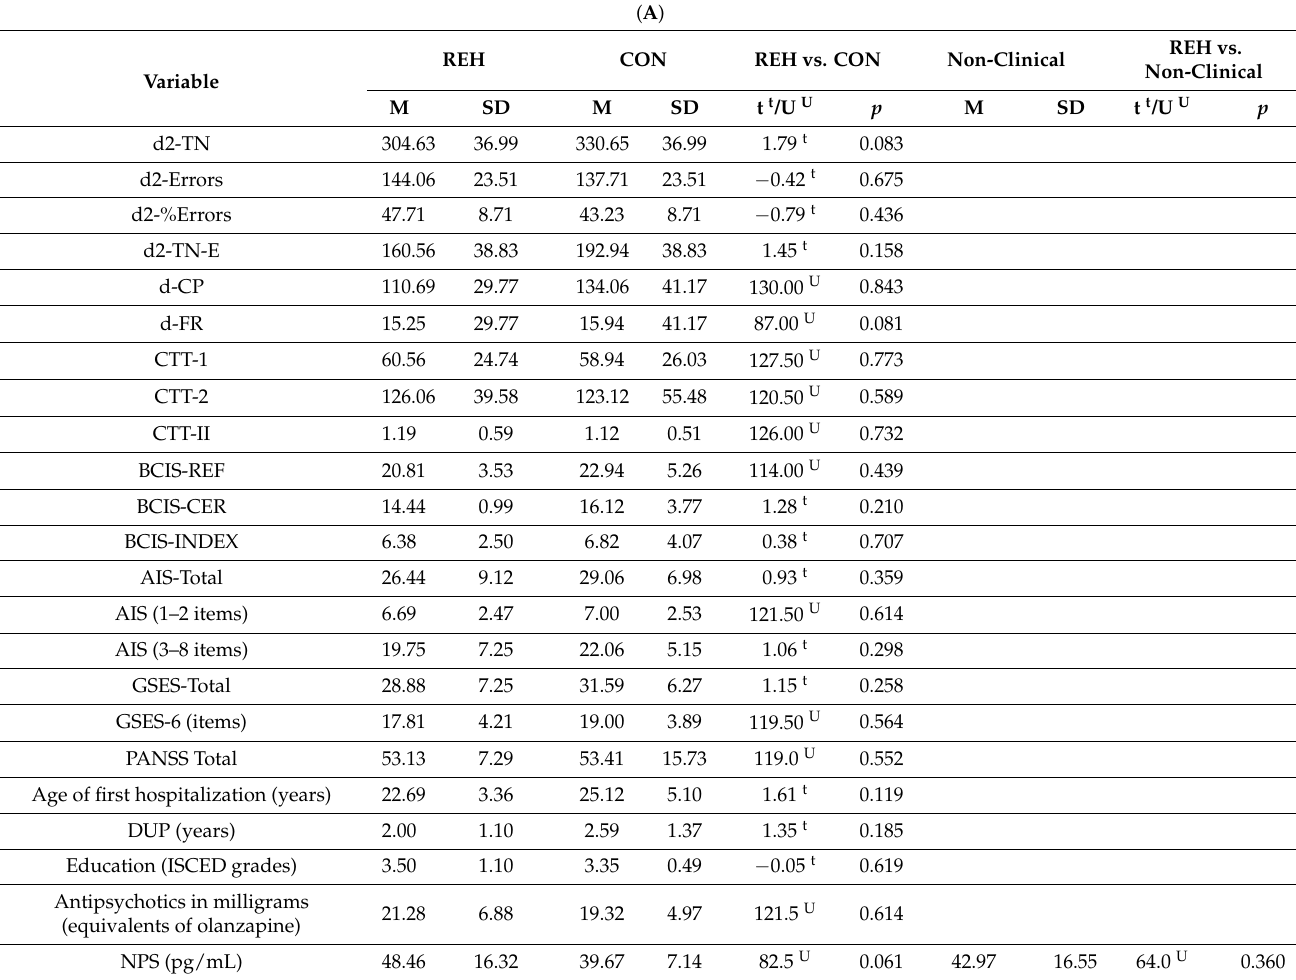
Table 1. Initial (T1) parameters and pairwise comparisons ( t test/Mann–Whitney test) for REH, CON and Non-clinical groups. ( A